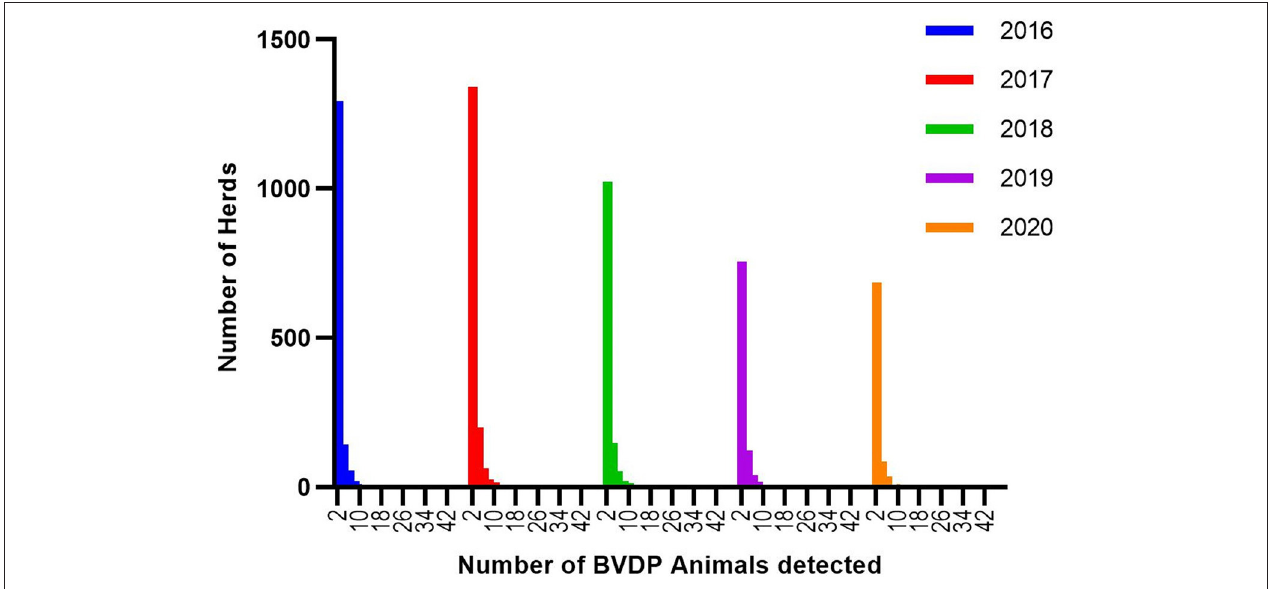
FIGURE 6 | The distribution of BVDv positive (BVDP) animals disclosed in each herd annually.